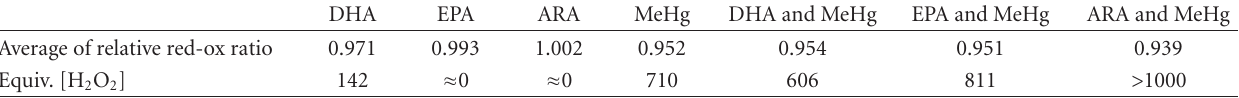
Table 2: Comparison of relative red-ox ratio to the known oxidative inducer H 2 O 2 in HEK293. DHA EPA ARA MeHg DHA and MeHg EPA and MeHg ARA and MeHg Average of relative red-ox ratio 0.971 0.993 1.002 0.952 0.954 0.951 0.939 Equiv. [H 2 O 2 ] 142 ≈ 0 ≈ 0 710 606 811 > 1000 Values below 12 are not significantly di ff erent from control, and oxidative stress is assumed almost zero. Calculations are made based on exponential curve fitting and its